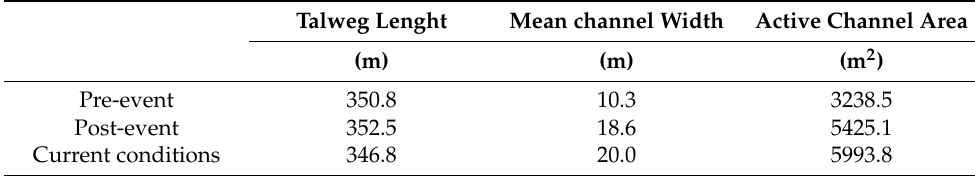
Figure 4. Visual planimetric changes of the active channel and talweg in the ( A ) pre-event, ( B ) post-event and ( C ) current periods. The yellow dot identifies the area where the grain size analysis was realized. Table 2. Planimetric evolution of the study